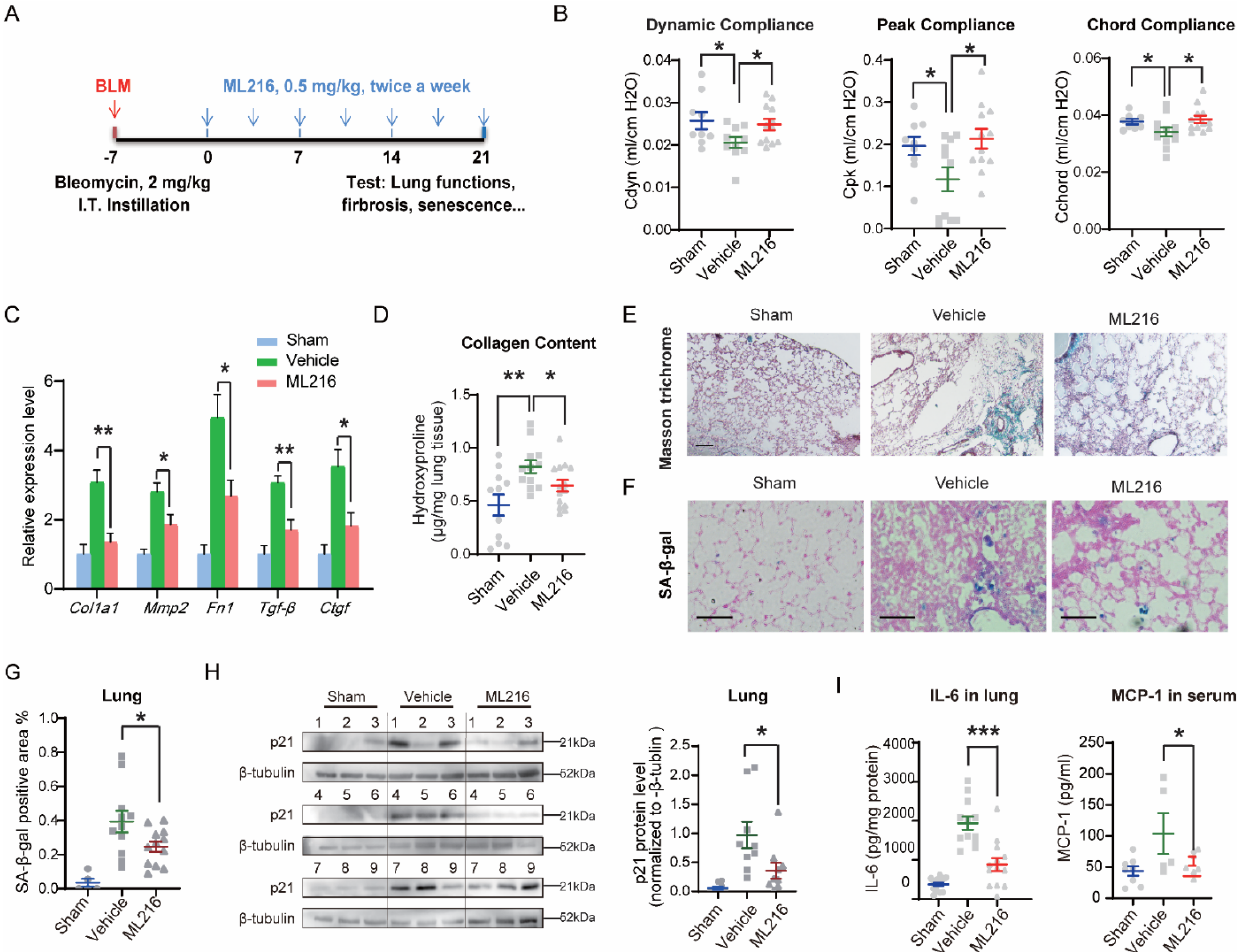
Figure 7. ML216 reduces senescence-associated pathological changes in IPF mice. ( A ) Schematic to illustrate the experimental design of bleomycin-induced lung fibrosis in C57BL/6J mice. ( B ) Measurements of the pulmonary function parameters: dynamic compliance, peak compliance and chord compliance in mice (Sham, n = 7–9; vehicle, n = 10–12; ML216, n = 12). ( C ) Gene expression levels of fibrosis marker genes COL1A1 , MMP2 , FN1 , TGF- β and CTGF in mice lungs ( n = 5 for each group). ( D ) The collagen content in mice lungs measured by hydroxyproline assay (Sham, n = 11; vehicle, n = 12; ML216, n = 14). ( E ) Representative images of the Masson’s trichrome staining of mice lungs. Scale bar = 100 μm. ( F ) Representative images and ( G ) the quantification of SA- β -gal-positive cells in mice lungs (Sham, n = 5; Vehicle, n = 11; ML216, n = 12). Scale bar = 100 μm. ( H ) Western blotting analysis of p21 protein levels in mouse lungs ( n = 9 for each group). The quantification of p21 by ImageJ are shown on the right. ( I ) Protein levels of SASP factors: IL-6 in lung and MCP-1 in serum, measured by ELISA assay (Sham, n = 5–13; Vehicle, n = 5–12; ML216, n = 7–13). In B, D, and G-I, the gray circles represent mice in sham group, the gray square represent mice in vehicle group, the gray triangles represent mice in ML216 group. All data are presented as mean ± SEM. 4. Discussion A multitude of data [38,46,47], including ours (Figure 2C), indicate that a lack of BLM accelerates senescence. According to our present findings, DBC1 acts as a protector of BLM, especially during DNA damage. As severe DNA damage occurs, activated caspases breakdown BLM, which presumably induces p21 and a subsequent state of senescence. This may serve as a salvage mechanism to retain tissue integrity by converting damaged cells into senescent cells instead of losing them to apoptosis. Excessive senescence induc- tion, however, can be detrimental. As a countermeasure, DBC1 protects BLM from degra- dation by binding to it, repressing p21 and the induction of senescence, thus preventing